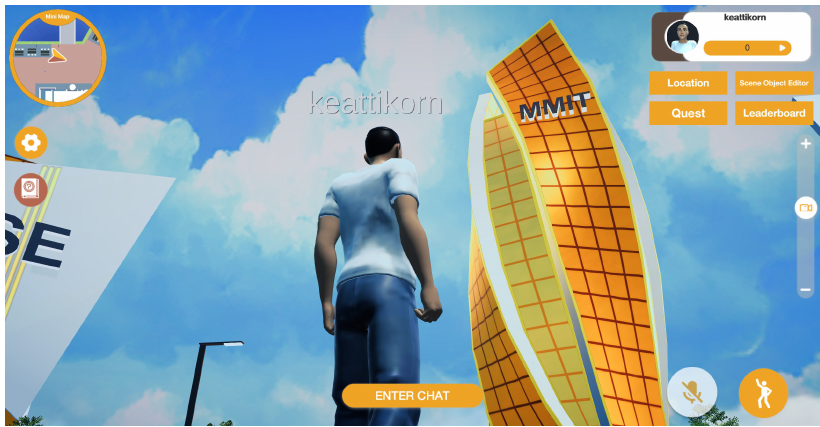
Figure 6. Modern management information technology (MMIT) building